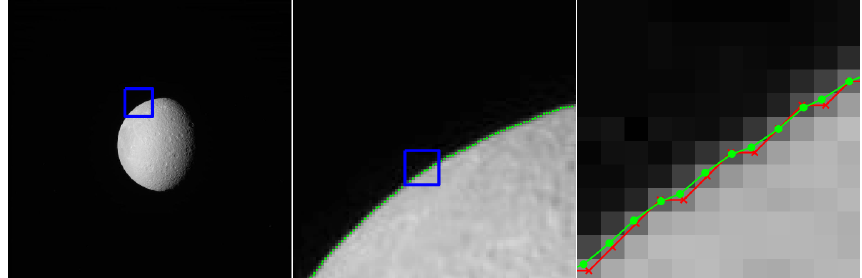
Figure 13. Image of Rhea (a moon of Saturn) collected by the Cassini spacecraft’s Narrow Angle Camera (NAC) on 13 October 2006 (raw image N1539252663 [31]), where we seek to localize the moon’s lit limb. The red symbols denote pixel-level edge estimates and green dots denote the refined × subpixel localization estimates.